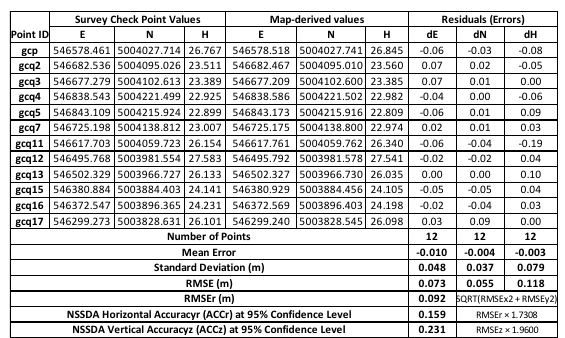
Table A1: Map Accuracy for the 2 Strip ISO, 50% sidelap - Railway Corridor